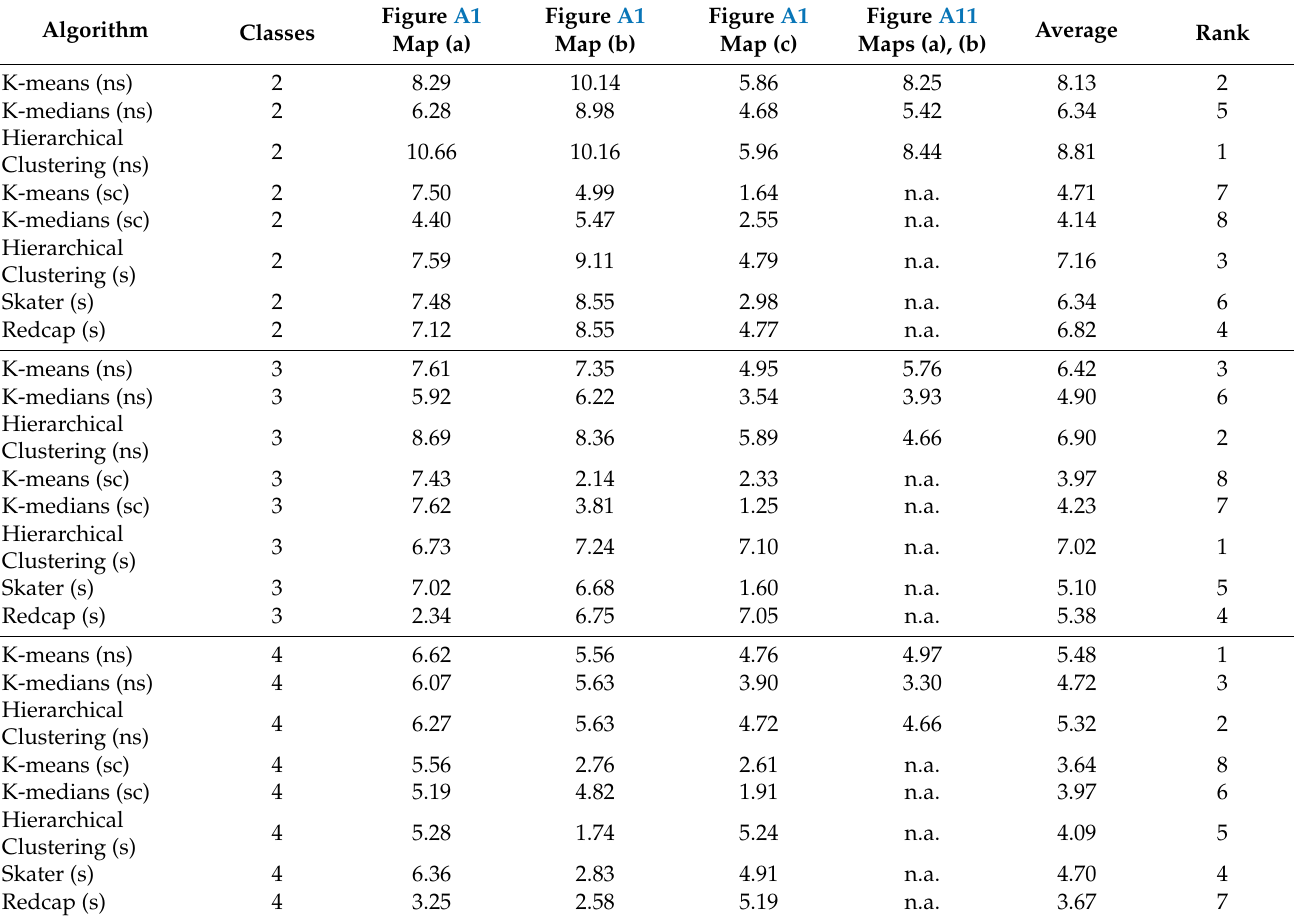
Table A2. Height differences (metres) between the highest cluster median height and next-lowest cluster median height. Spatially constrained K-means and K-medians have the smallest spread between these height classes, while the other spatial algorithms have a larger spread but are still less than the nonspatial methods. n.a. = algorithm not